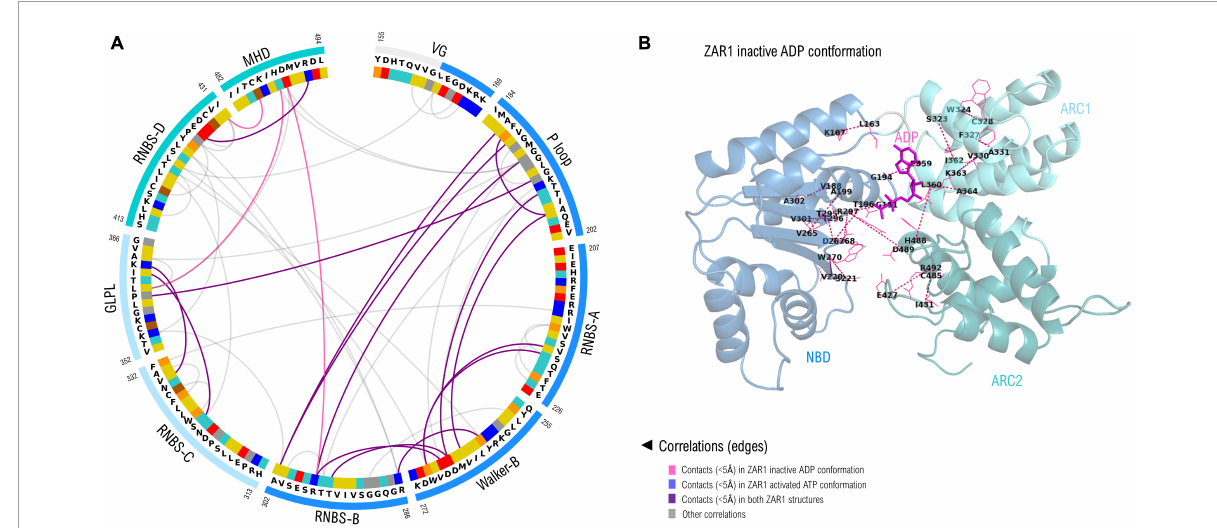
FIGURE5 (A) Correlated amino acid pairs within the nine NBS motifs. Correlations endorsed by 3D space proximity ( < 5Å) in ZAR1 inactive ADP cryo-EM structure (6j5w) are shown in violet, while contacts found also in pentameric ATP structure (6j5t) are shown in purple. Correlations not supported by 3D proximity are depicted in gray and were computed using VisualCMAT (Suplatov et al., 2018). Amino acid color code is detailed in Figure 2 caption. (B) Correlated interaction pairs mapped onto the cryo-EM inactive ZAR1 structure (PDB: 6j5w). Amino acid pairs are depicted with dotted lines. Domain color code is as in (A) : NBD, blue; ARC1, light blue; ARC2,